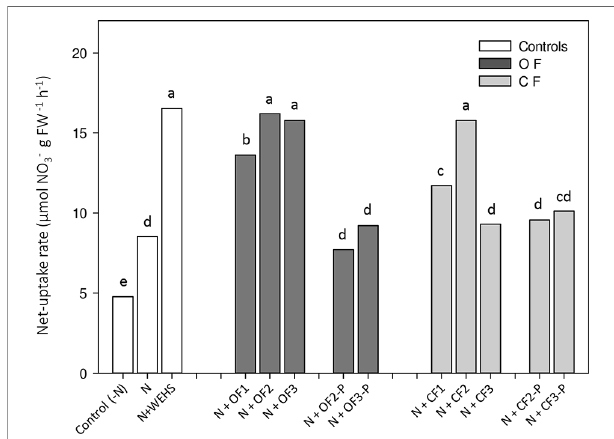
FIGURE 3 | Net uptake rates of nitrate by roots of maize plants exposed for 4 h to humic substances of different origin. White bars , As controls, plants exposed to N-free nutrient solution [ Control (-N) , or nutrient solution containing nitrate (0.5 mM Ca(NO 3 ) 2 ) with or without water-extractable humic substances (WEHS) (5 mg C org L − 1 ; N+WEHS or N , respectively). Dark gray bars , Plants exposed to nutrient solution with nitrate and dissolved